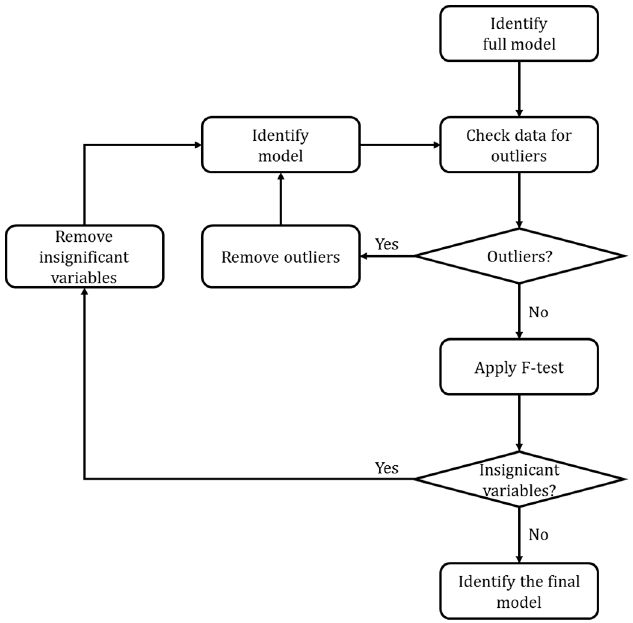
Figure 4. The modelling scheme applied.